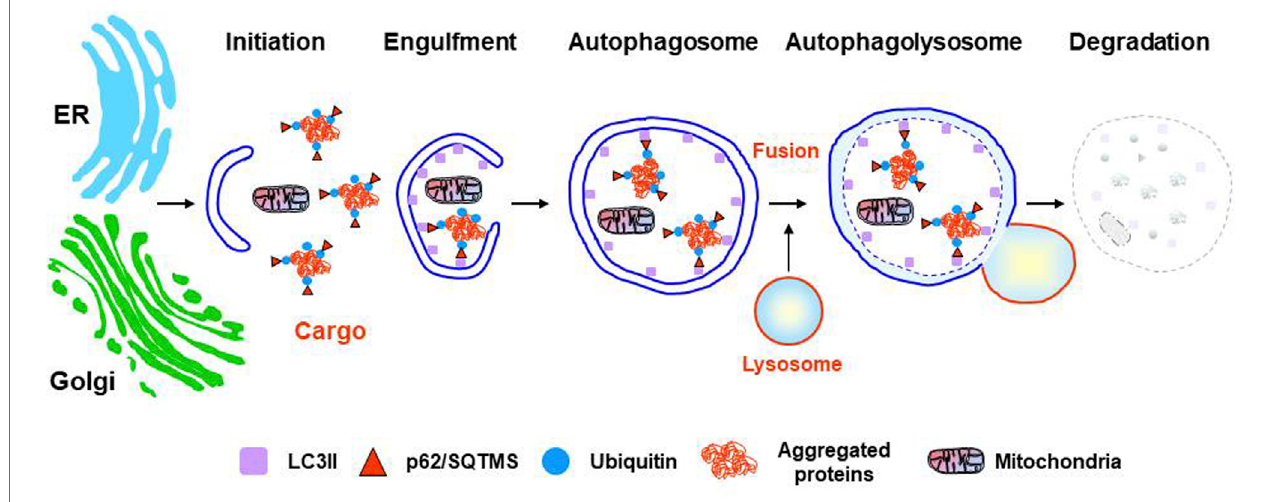
FIGURE 2 | Stages of the autophagy lysosomal pathway. From initiation to resolution the most relevant markers are shown. Two potential sources of autophagosome membranes, but not the only ones, are indicated: ER (endoplasmic reticulum) or